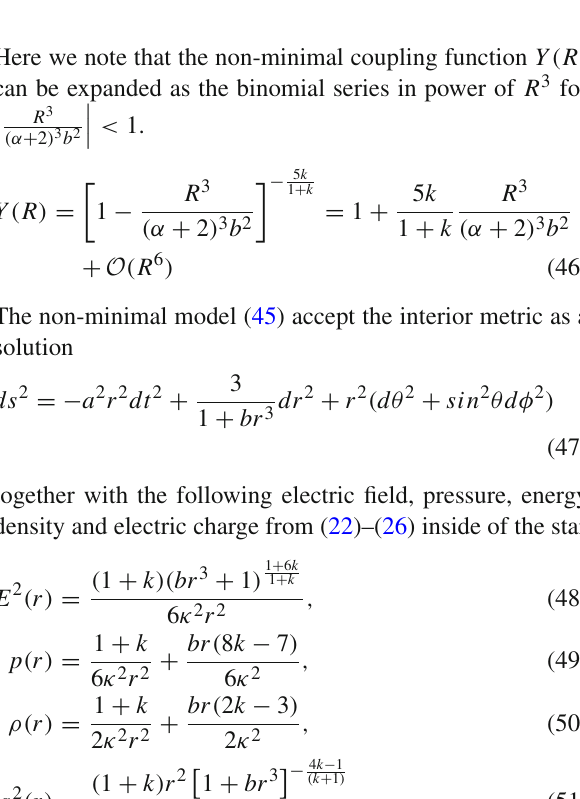
Fig. 3 Variation of the dimensionless quantity which is related with the gravitational mass M and the gravitational surface redshift z as a function of the dimensionless parameter α for some different k values